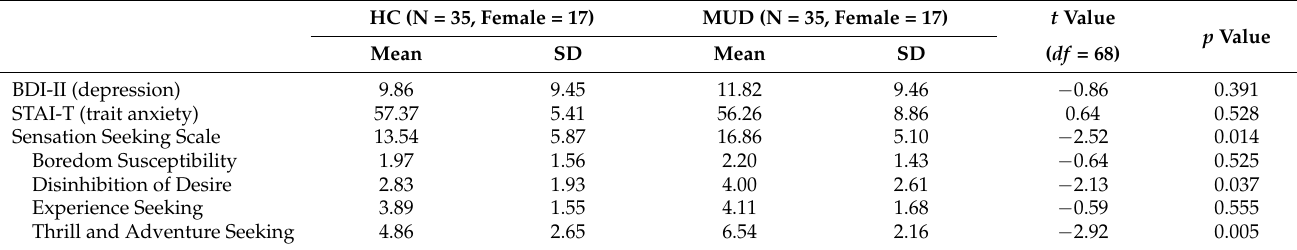
Table 2. Questionnaire